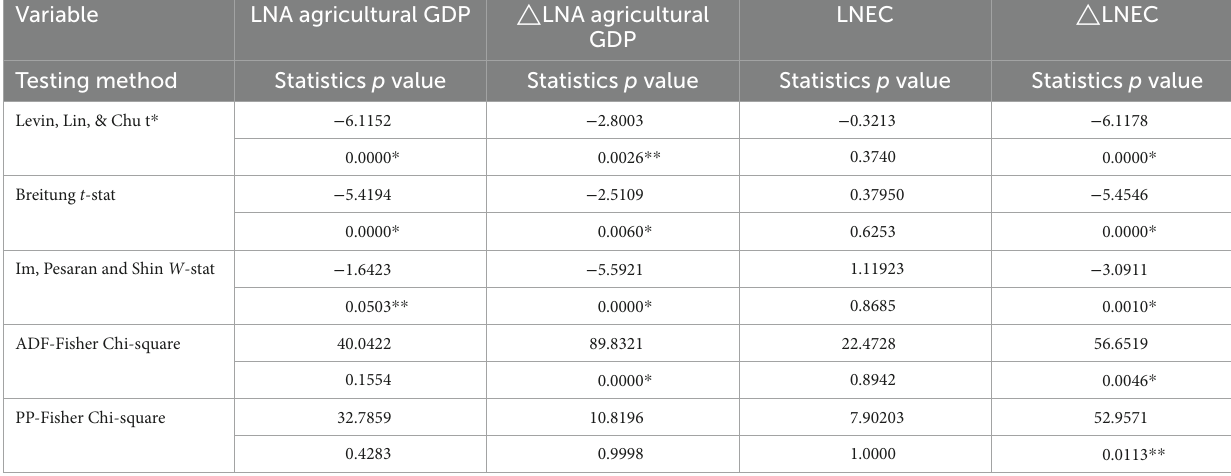
TABLE 2 Unit root test results of each variable in Class II blocks.